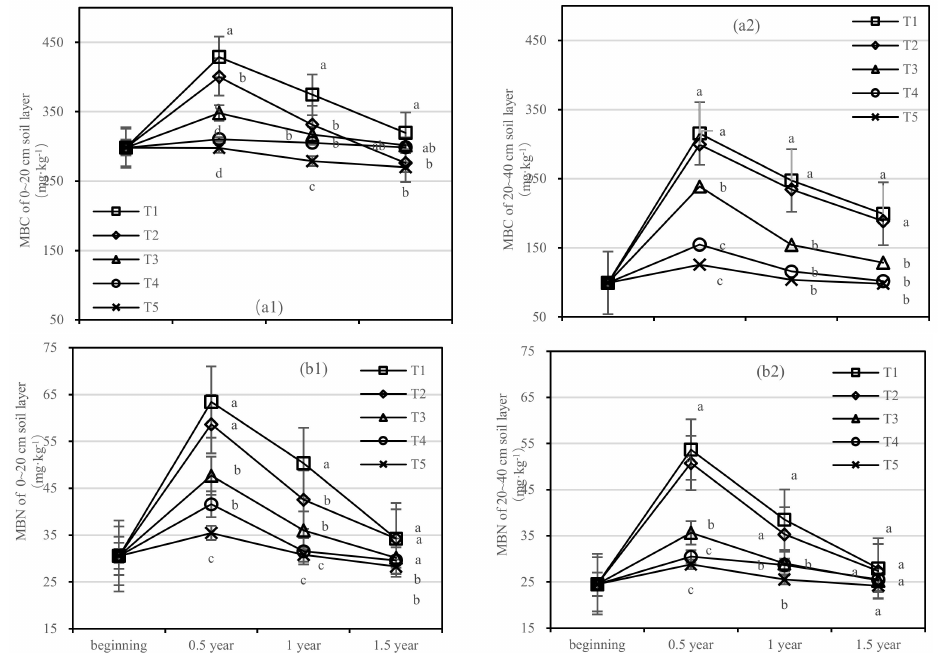
Figure 5. Soil microbial biomass carbon (MBC) and nitrogen (MBN) in four periods under five fertilization types. Data are the mean content ± standard deviation. Letters represent differences ( α = 0.05). T1: adjustment of C/N and C/P + 0.2% priming; T2: adjustment of C/N and C/P +